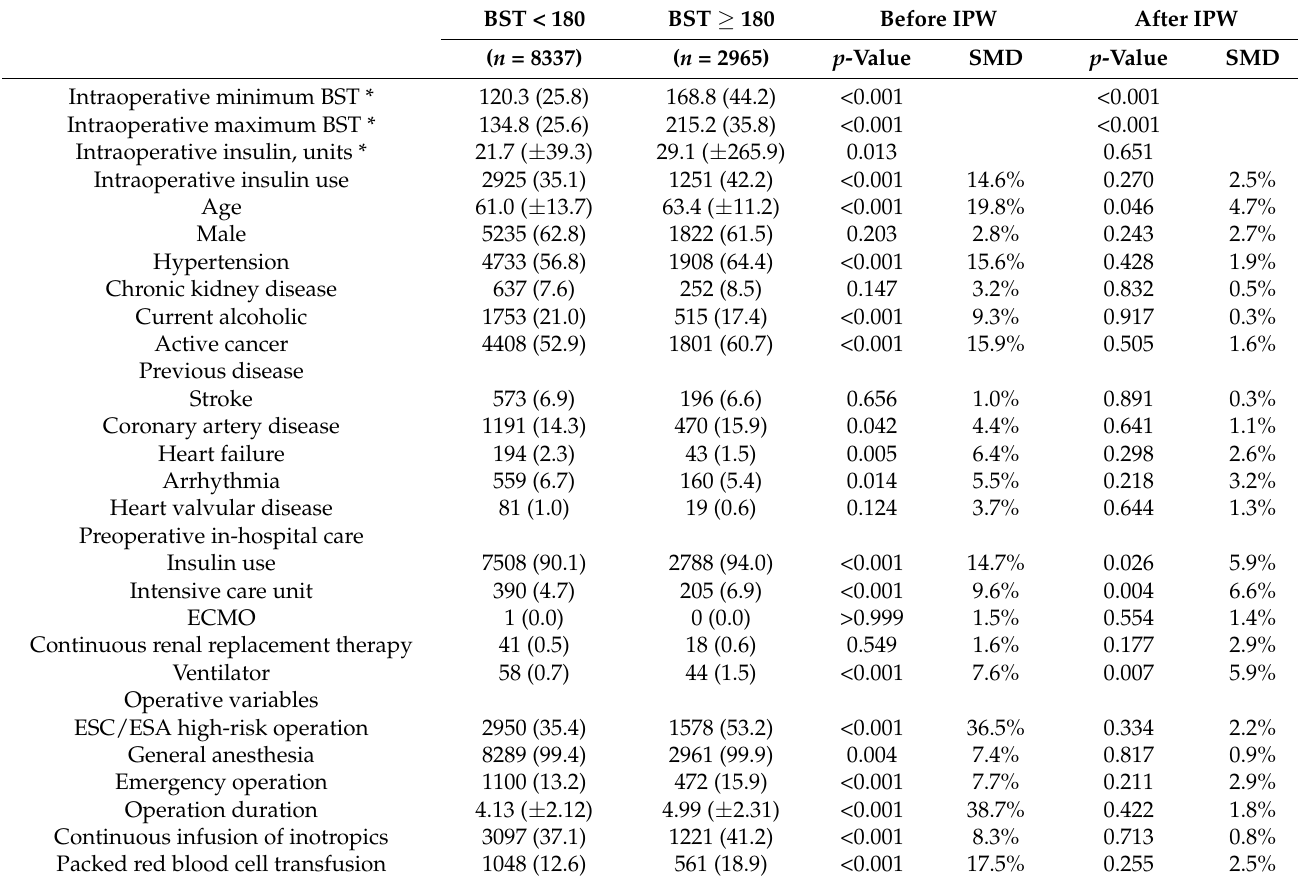
Table 1. Baseline characteristics according to intraoperative blood glucose level.